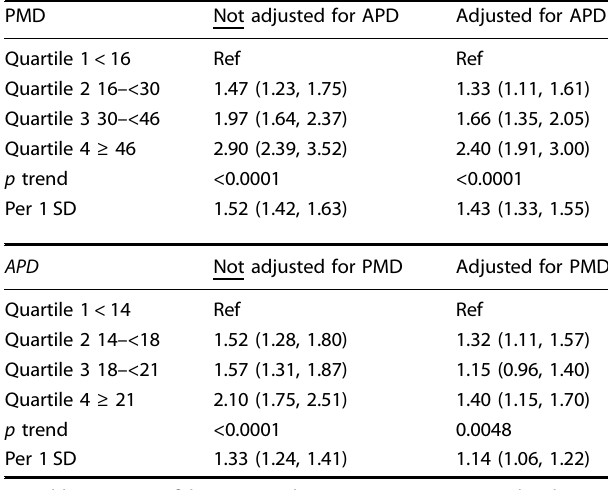
Table 4. ORs and 95% CIs for the associations between breast cancer risk and APD and PMD with mutual adjustment, in NHS/NHSII a .